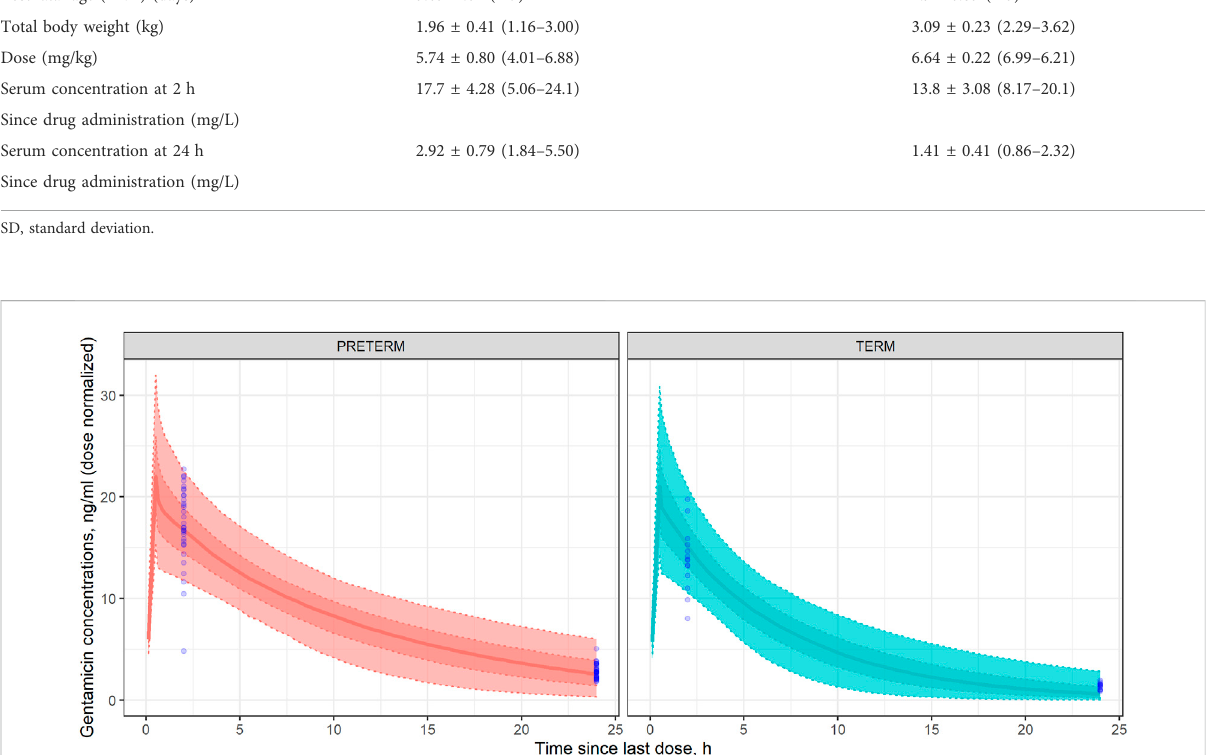
FIGURE 2 Visual Predicted Check (VPC) in preterm (left) and term (right) neonates. Dotted lines represent, from the bottom to the upper panel, the 10th, 25th, 75th, and 90th percentiles of the gentamicin concentrations simulated vs. time. Shaded areas represent, from outside to inside, the 90% and 50% prediction intervals. Solid lines represent the median gentamicin simulated concentration-time pro fi le. Open blue circles represent the observed gentamicin concentrations